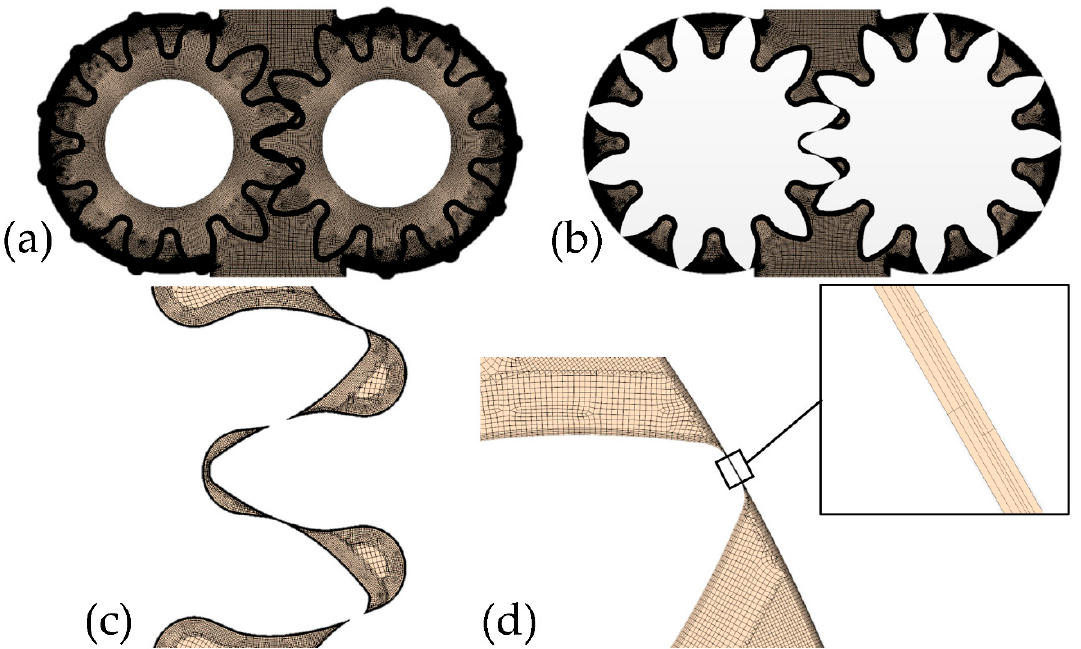
Figure 5. Overset mesh approach: ( a ) Quadrilateral mesh of the background and overset regions; ( b ) initialized overset interfaces; ( c ) zoomed view of the gears’ meshing region; ( d ) zoomed view of the mesh in the 10- µ m radial gap.